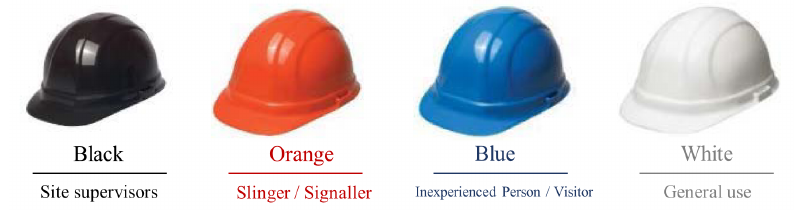
Figure 2. Helmet colors and the roles on construction sites